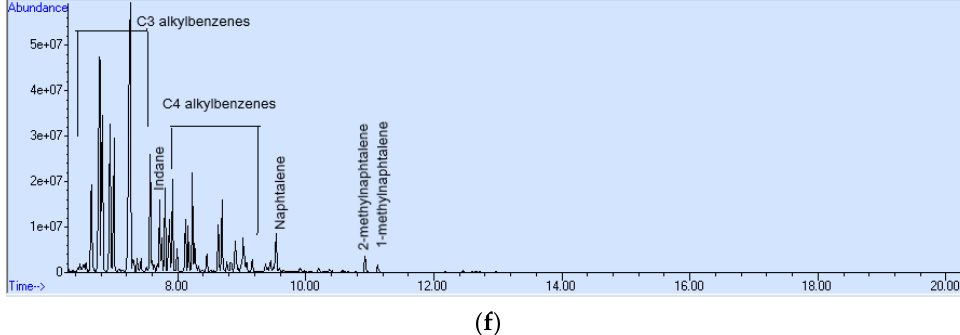
Figure 2. Total ion chromatogram (TIC) of ( a ) crude oil and petroleum products samples: ( b ) heating oil, ( c ) bunker oil, ( d ) diesel fuel, ( e ) gasoline, and ( f ) jet fuel. Cx = n ‐ alkanes with x carbon atoms, Cx:y = fatty acid methyl esters with x carbon atoms, and y unsaturation. Ph: phytane, Pr: pristane.